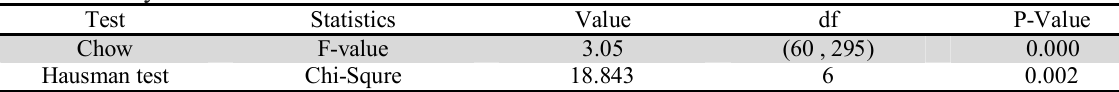
The summary of Hausman and Chow tests